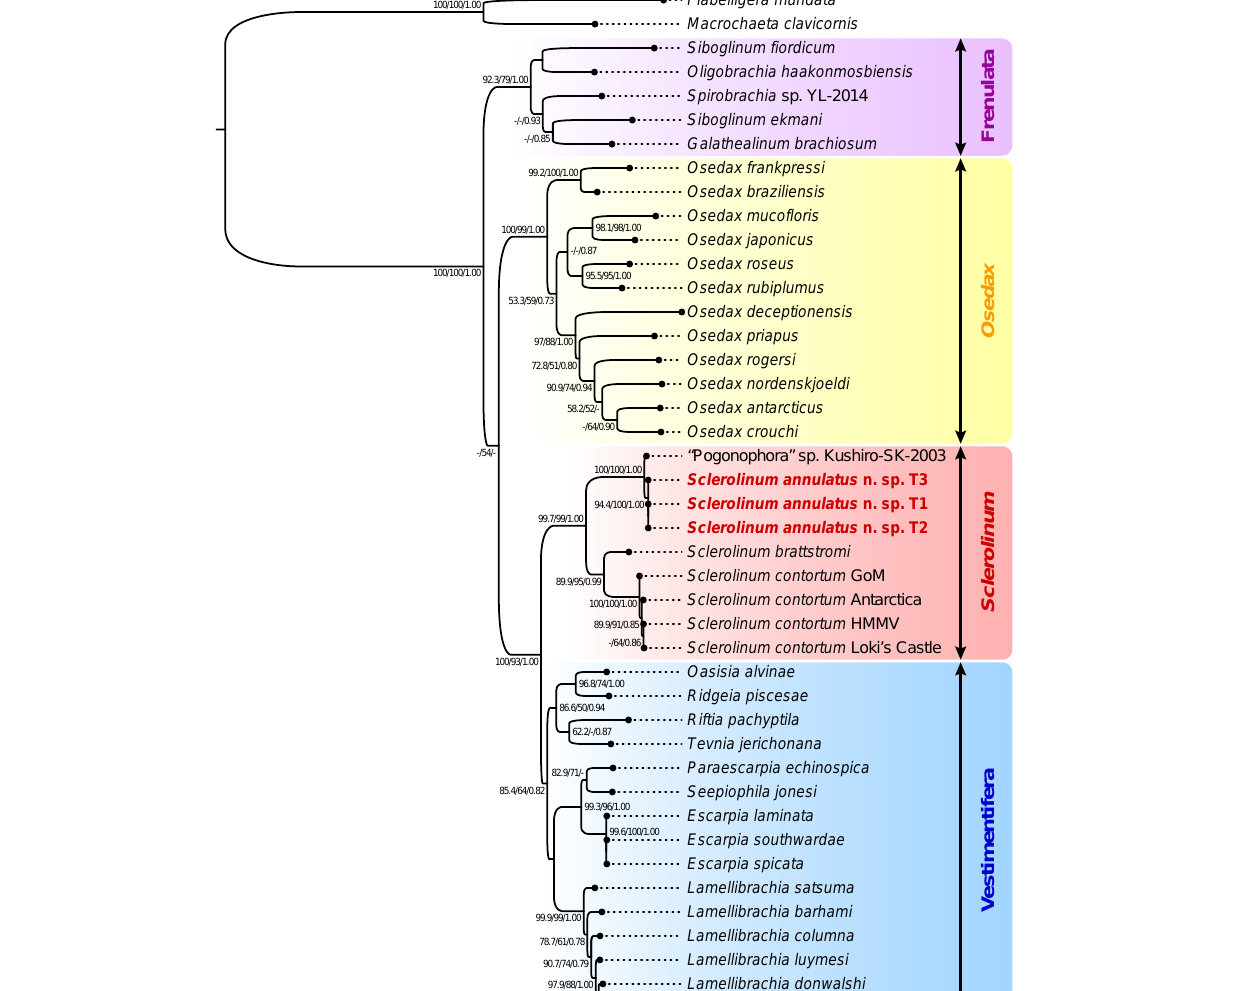
and a 1,735-bp alignment 18S rRNA from 29 siboglinids